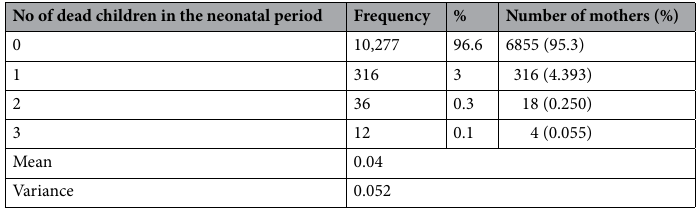
Table 1. Distribution of neonatal mortality per mother.